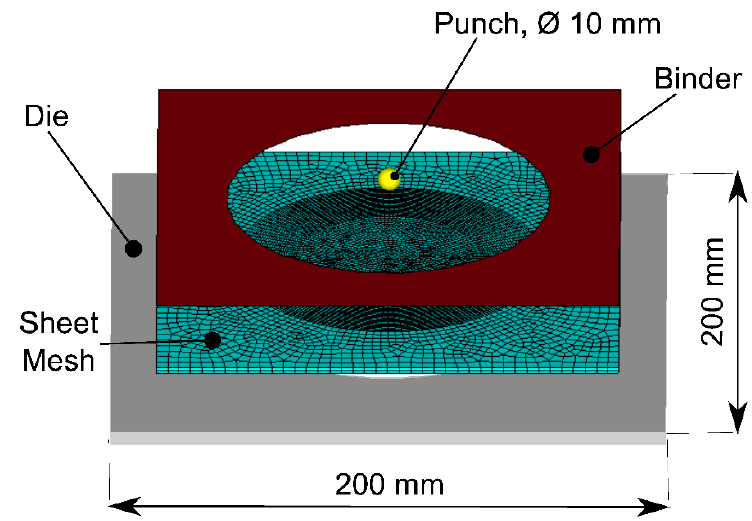
Figure 2. FEM model for the SPIF process.